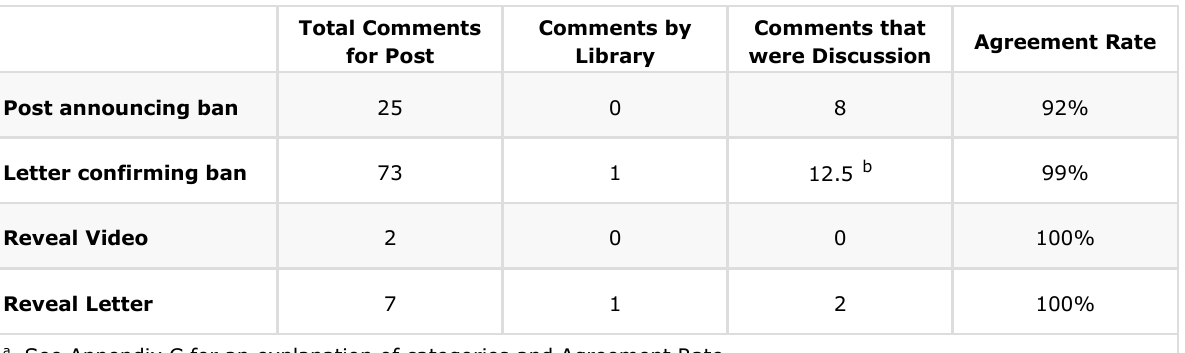
Library Participation and Amount of Discussion: Number of Comments